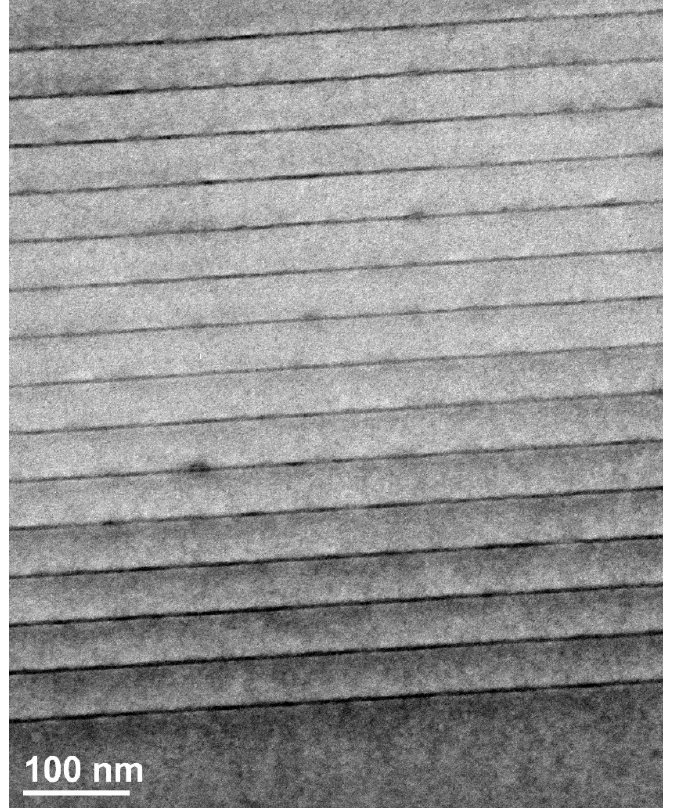
Figure 4. Cross-section images in the [1–10] zone of the 15 stacked In 0.4 Ga 0.6 As QWD layers.